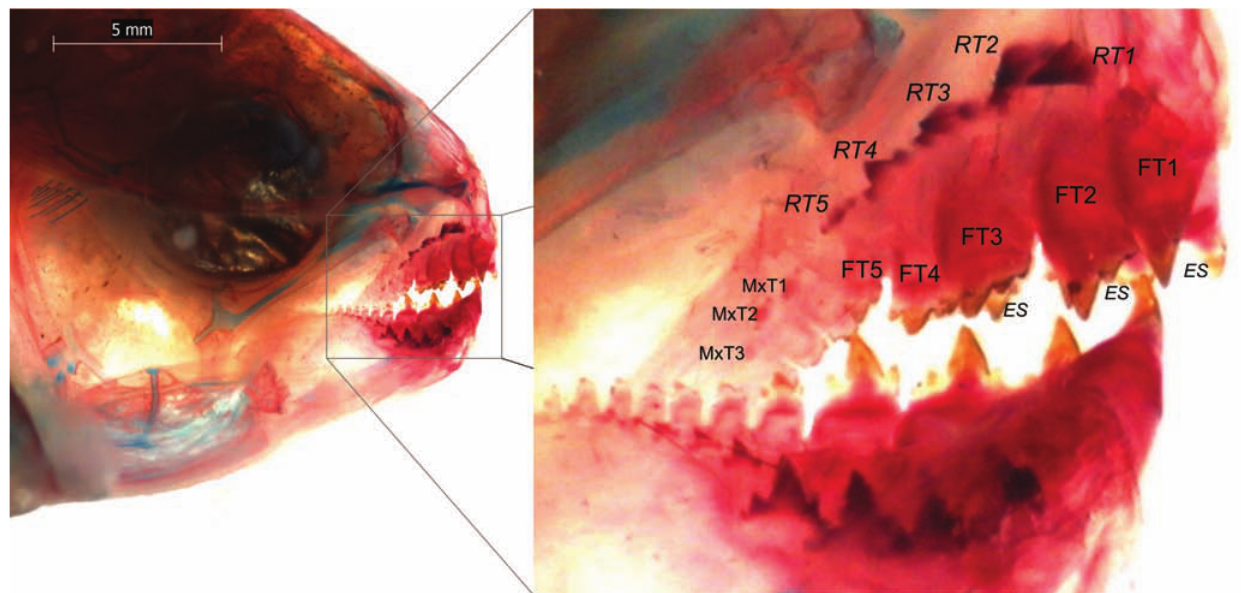
Fig. 2. Astyanax eremus , new species, MCP 46942 (71.9 mm SL), paratype. Medial view of left side of the head with mouth region enhanced. Tooth of the outer premaxillary row (ES). Functional tooth of the inner premaxillary row (FT). Tooth of the maxillary bone (MxT). Replacement tooth of the inner premaxillary series (RT).